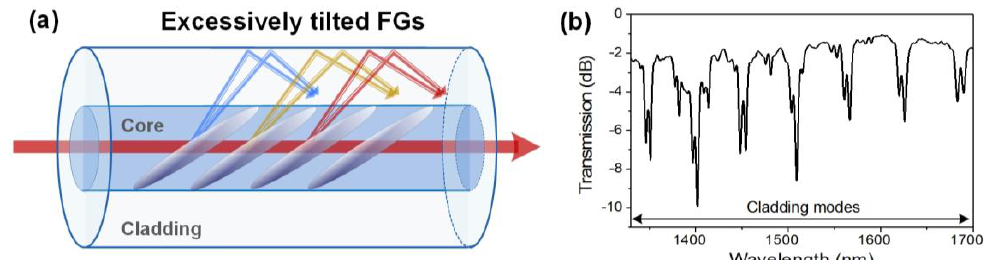
Figure 4. ( a ) Sketch of the light mode coupling in an excessively tilted fiber grating (ETFG); and ( b ) transmitted amplitude spectrum of a 1 cm-long ETFG.